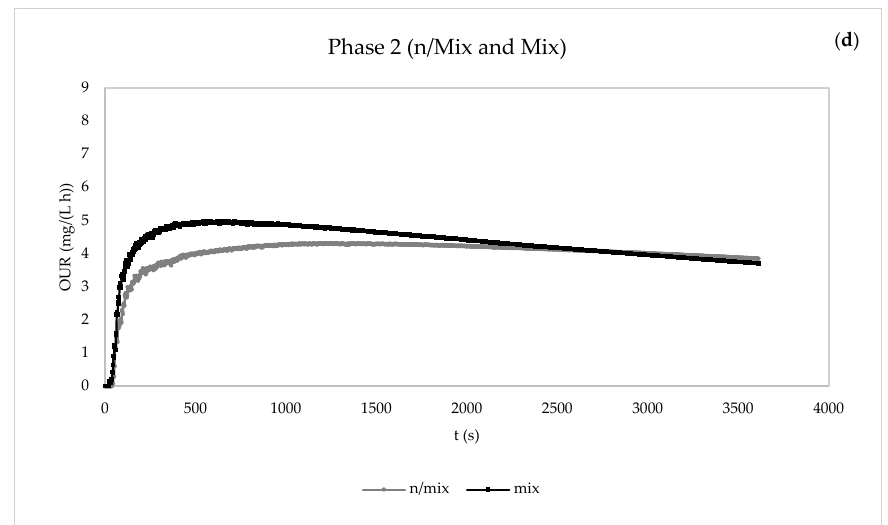
Figure 7. Evolution of static oxygen uptake rate (OUR) in the respirometric experiments in the absence and presence of pollutants for the determination of the kinetic parameters. ( a ) Phase 2: control without BPA and with BPA. ( b ) Phase 2: control without carbamazepine and with carbamazepine. ( c ) Phase 2: control without ciprofloxacin and with ciprofloxacin. ( d ) Phase 2: control without pharmaceuticals and with mixture of pharmaceuticals. n/BPA: absence of bisphenol A. BPA: presence of bisphenol A. n/CBZ: absence of carbamazepine. CBZ: presence of carbamazepine. n/CPF: absence of ciprofloxacin. CPF: presence of ciprofloxacin. n/Mix: absence of mix of pharmaceuticals. Mix: presence of mix of pharmaceuticals. Table 5. Kinetic parameters obtained using Equations (1)–(8) for phase one (1) and two (2) of experi- ments at operation temperature existing in plant (where Mix—the mixture of the three compounds; µ m —the maximum specific growth rate of heterotrophic biomass; K M —the half-saturation coefficient of organic matter; Y H,O2 —the yield coefficient of heterotrophic biomass referred to oxygen; b H —the decay coefficient of heterotrophic biomass; r su,H —the substrate degradation rate of organic matter removal; and r’ x,H —the net heterotrophic biomass growth